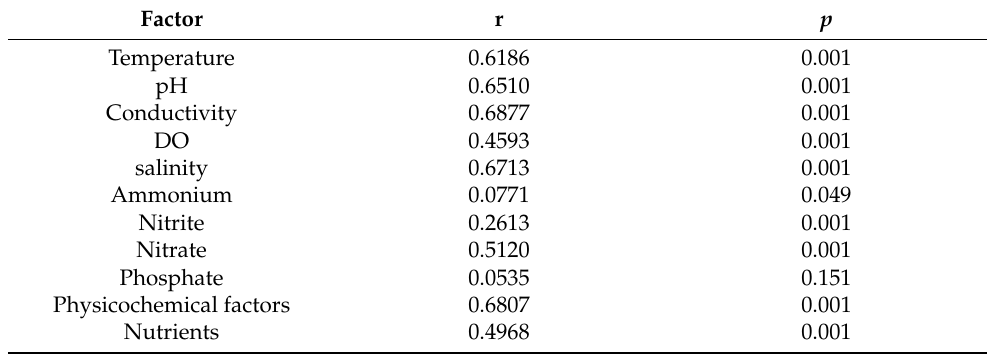
Table 3. Mantel test of the effects of environmental factors on the bacterial community